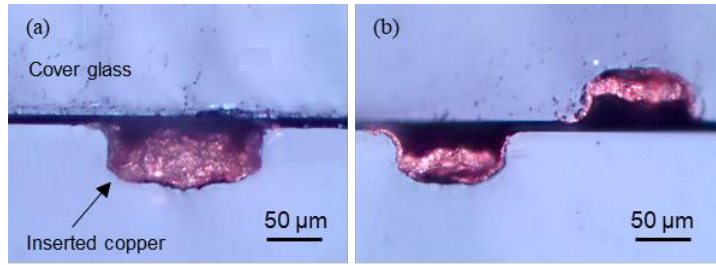
Figure 13. Cross section images of ( a ) a fully filled 150 µm wide channel sealed with cover glass; and ( b ) two layers of half-filled 100 µm wide channels stacked without supports.